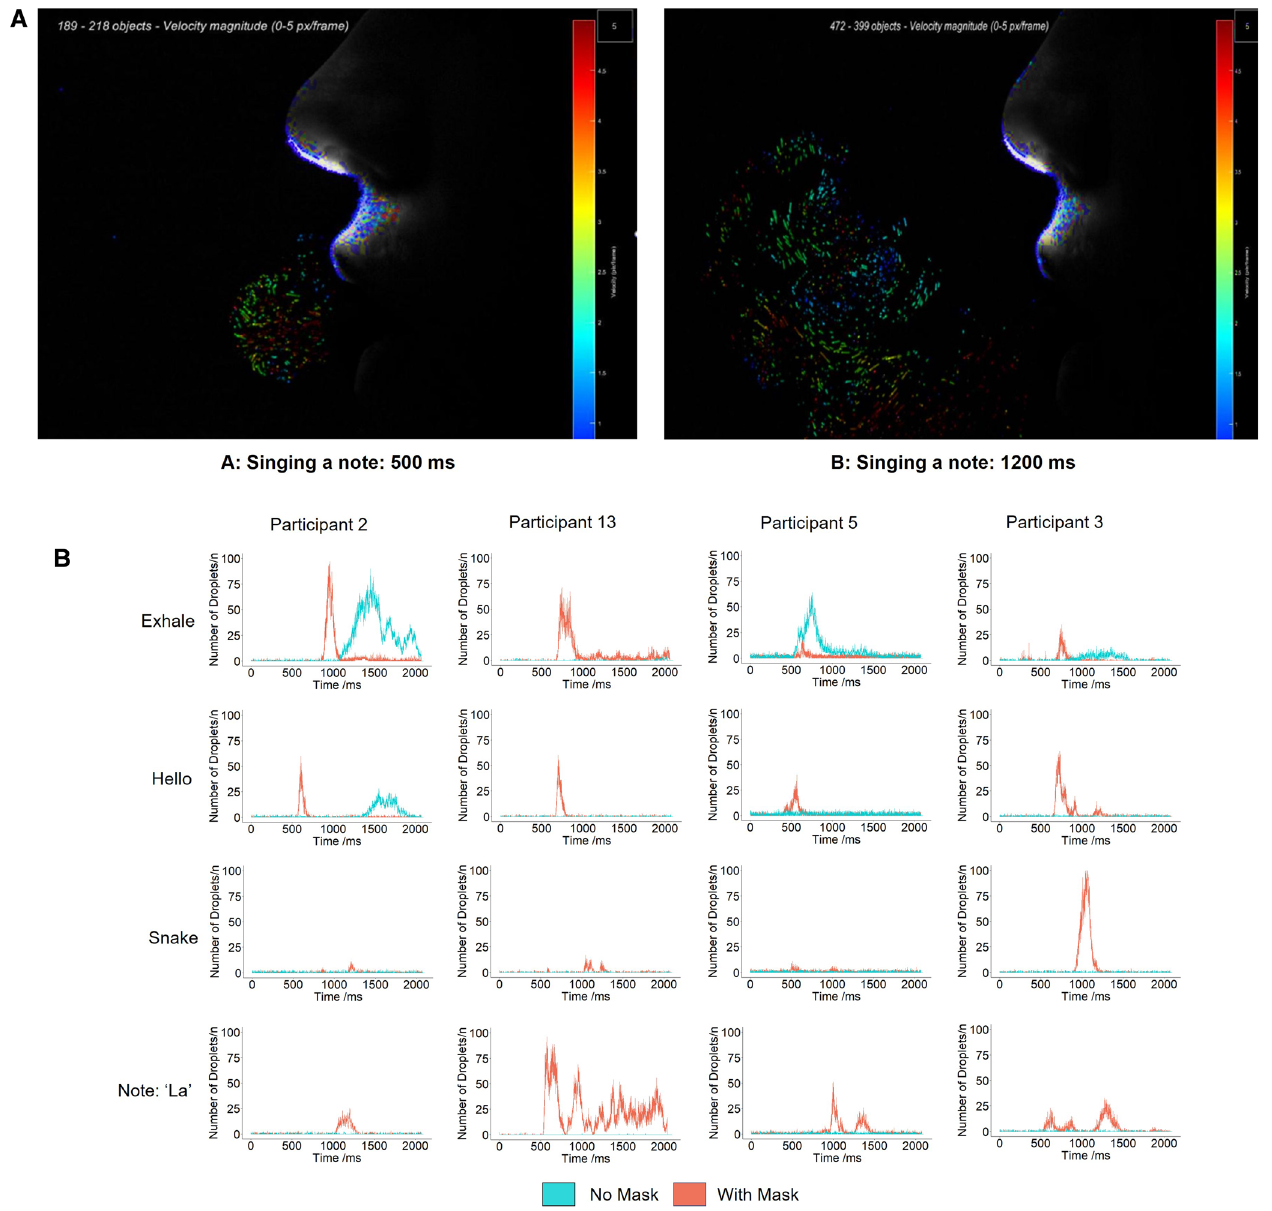
Figure 2. Panel ( A ): Representative images showing time vector plots of droplets being produced. Colours show velocity and arrows show direction of movement of each individual droplet. These images are taken from 500 and 1200 ms after one of the participants sang the note ‘la’. These data were analysed to create the graphs in panel ( B ). A full video sequence is available as Supplementary Video 1. ( B ) Representative time resolved transmission of droplets. There was no consistent pattern for numbers of droplets produced across the various tasks. Leakage through the mask occurred almost exclusively during exhaling. Otherwise, virtually no droplets were transmitted for any task when wearing masks. Figures produced in R software 4.0.4 34 using the ggplot2 package 35